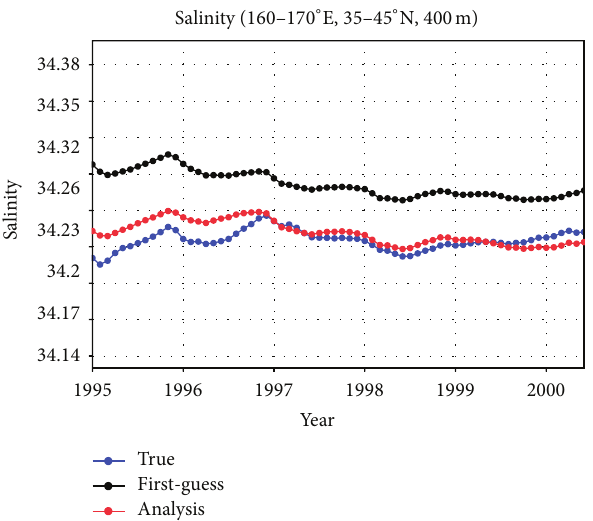
Figure 3: Time series of salinity values at 400m depth (closely corresponding to the 26.6 𝜎𝜃 isopycnal surface) averaged over the region bounded by 35 ∘ N–45 ∘ N and 160 ∘ E–170 ∘ E, within the region where virtual concentrated observational data were synthesized (Figure